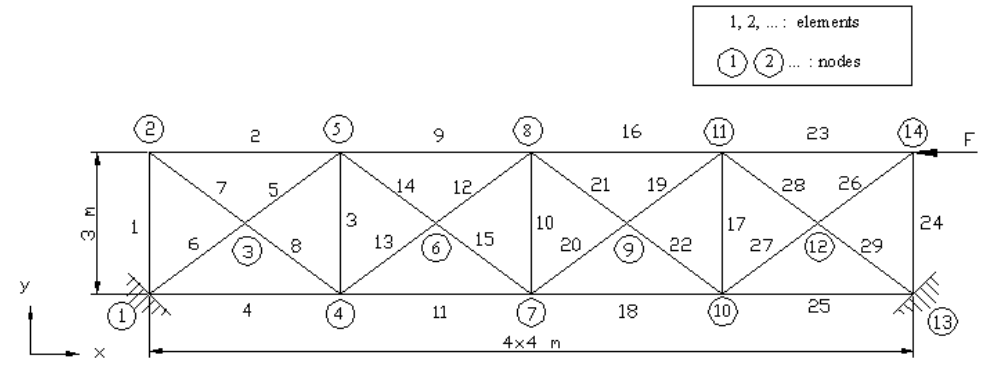
Fig. 3. Structure out of lattice doubly embedded.